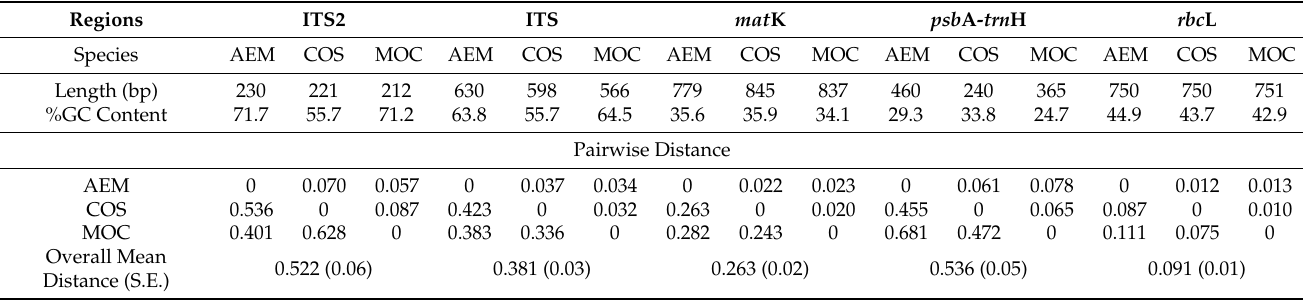
Table 3. Sequence Analysis and Pairwise Distance of Aegle marmelos (L.) Corr ê a (AEM), Coriandrum sativum L. (COS), and Morinda citrifolia L.